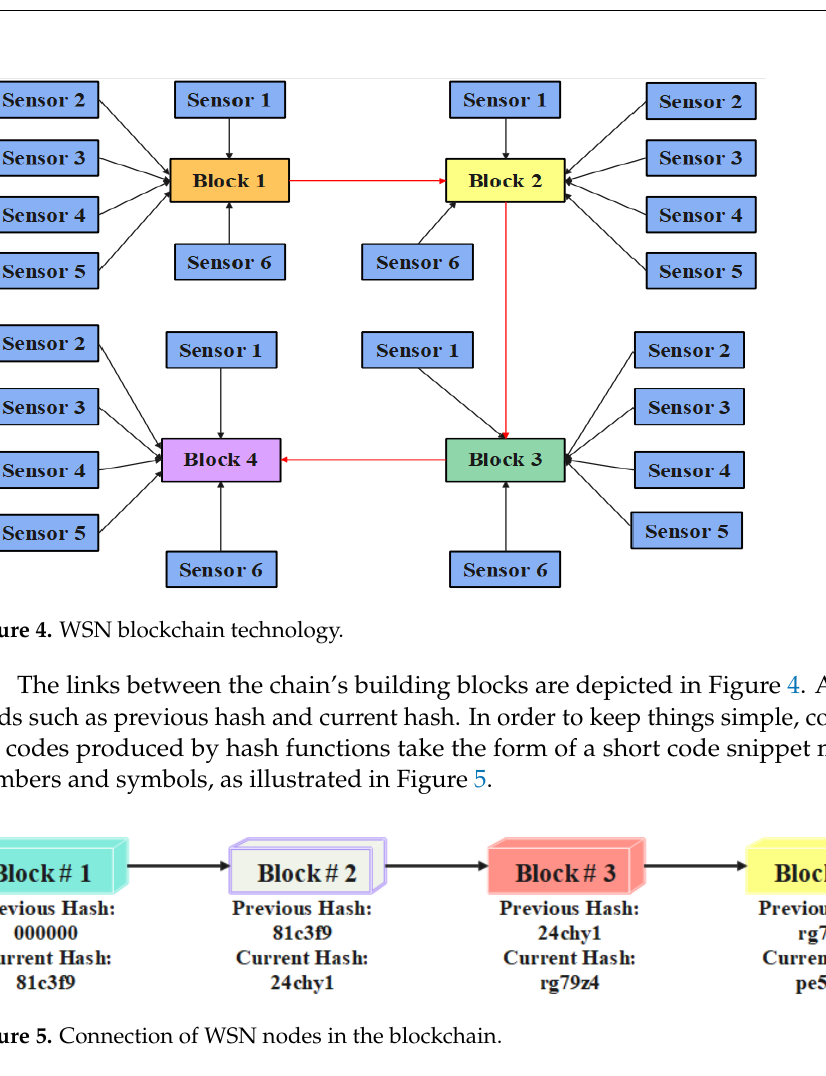
Table 1. Simulation parameters.